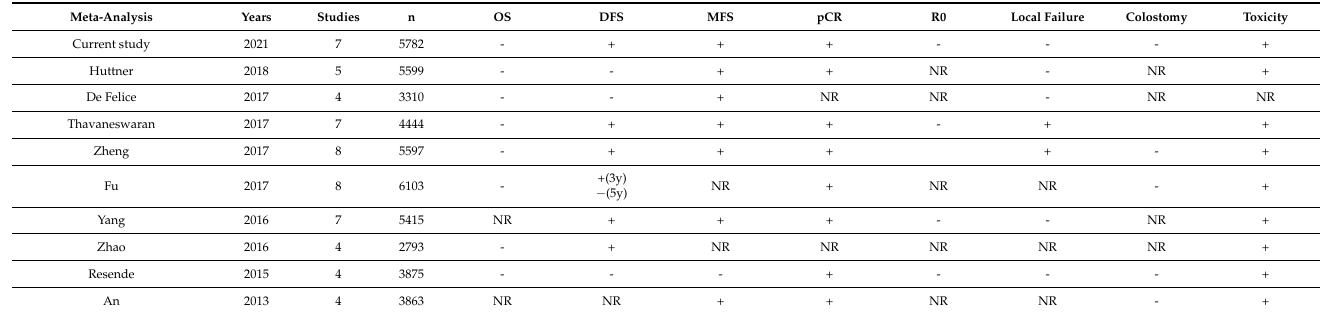
Table 3. Previous meta-analysis